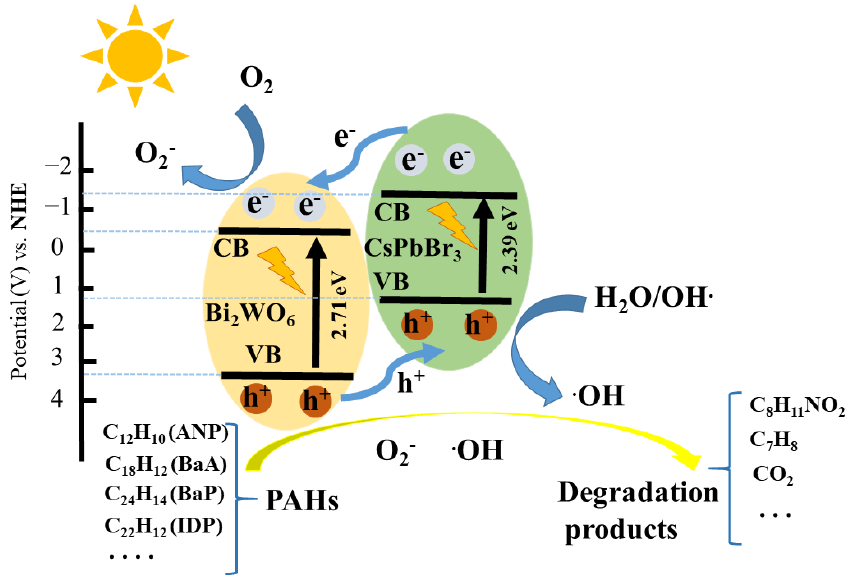
Figure 7. Schematic photocatalytic reaction process and charge transfer of the CsPbBr 3 /Bi 2 WO 6 composite catalyst under solar light irradiation.